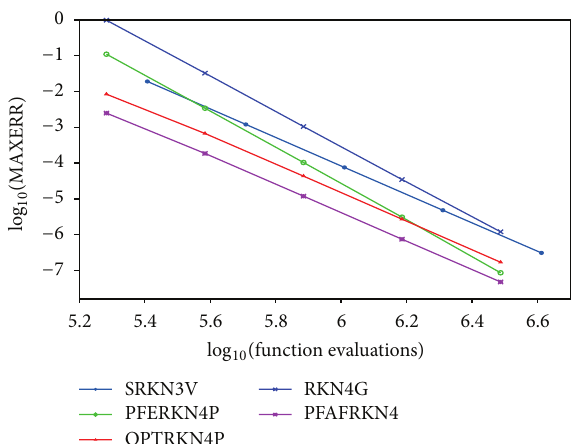
Figure 1: Efficiency curves for all methods for Problem 1 with 𝑒 = 0 and ℎ = 1/2 𝑖 , 𝑖 = 3, ...,7 .